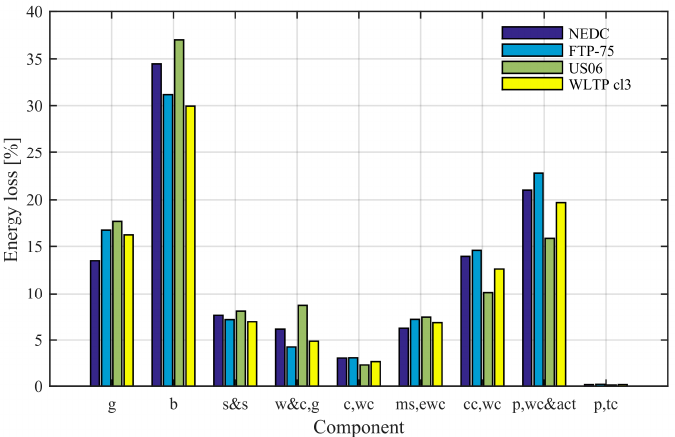
Figure 6. Comparison between experimental and simulation fuel consumption results for the case study vehicle equipped with the DCT, along the New European Driving Cycle (NEDC).